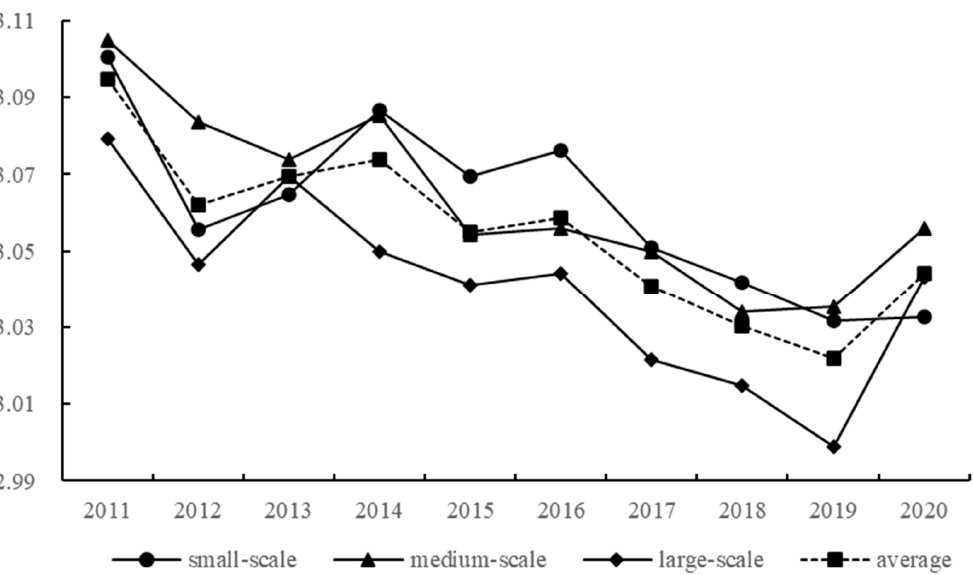
Figure 2. Annual feed-to-meat ratio of hog production of different scales in China from 2011 to 2020.